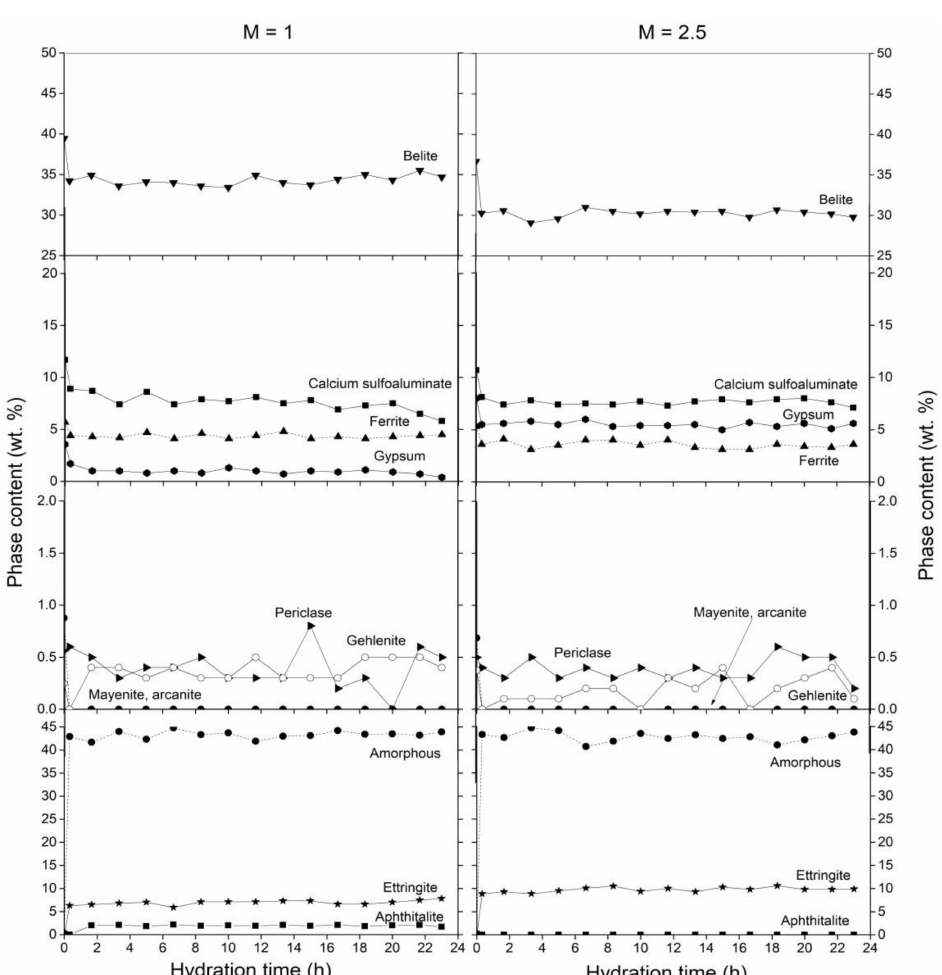
Figure 5. Phase content in the cement pastes with M = 1 and M = 2.5 cured at 40 ◦ C during the first 24 h of hydration.